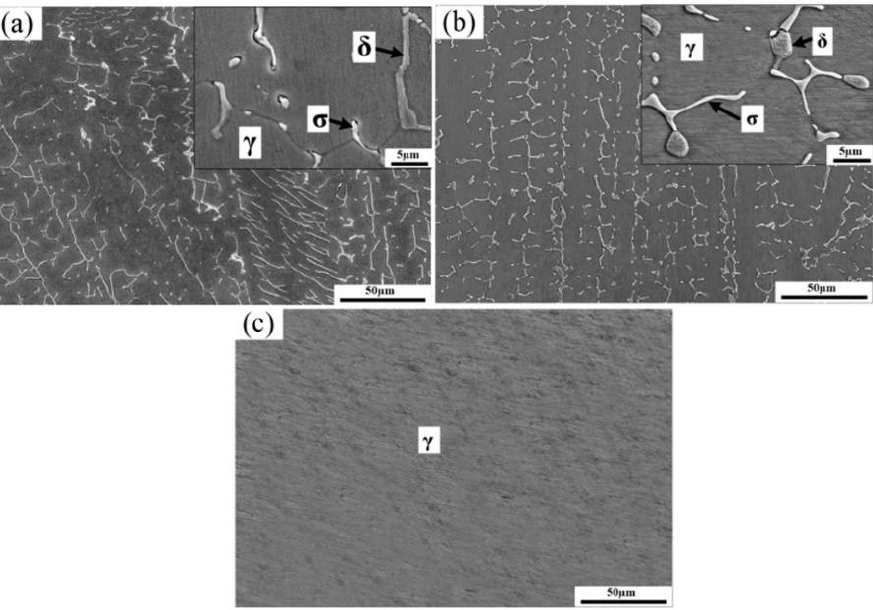
Figure 8. Microstructures of as-deposited and heat-treated GMA-AM 316L: ( a ) as-deposited, ( b ) solid solution treatment 1000 °C/1 h, water quenching (WQ), and ( c ) 1200 °C/4 h, WQ. Reprinted with permission from [59], Copyright 2018 Elsevier.